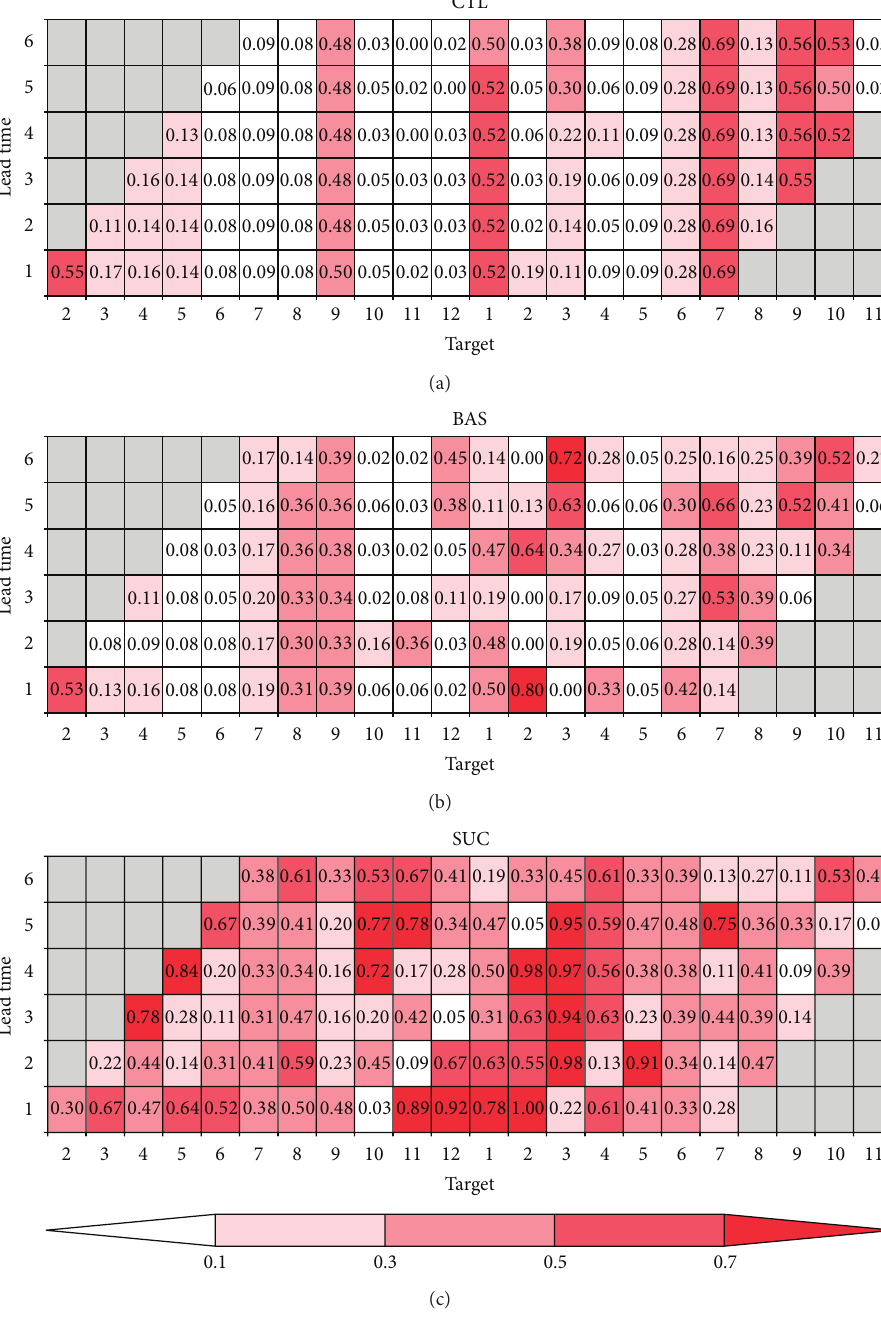
Figure 8: Skill scores (SS) for different lead times (vertical axis) and different target months (horizontal axis) for the CTL (a), BAS (b), and SUC (c)